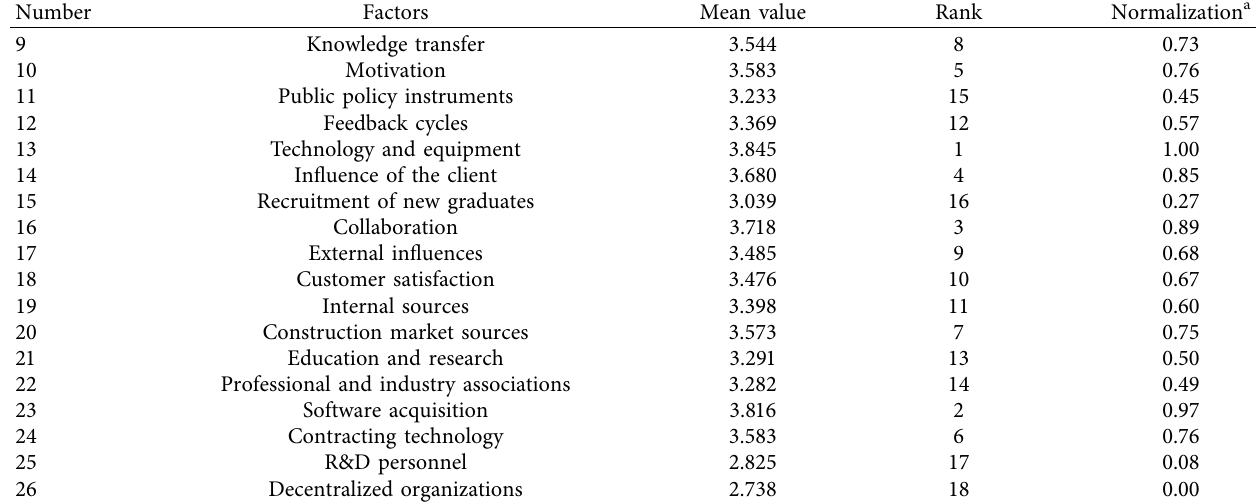
Table 3: Ranking of the